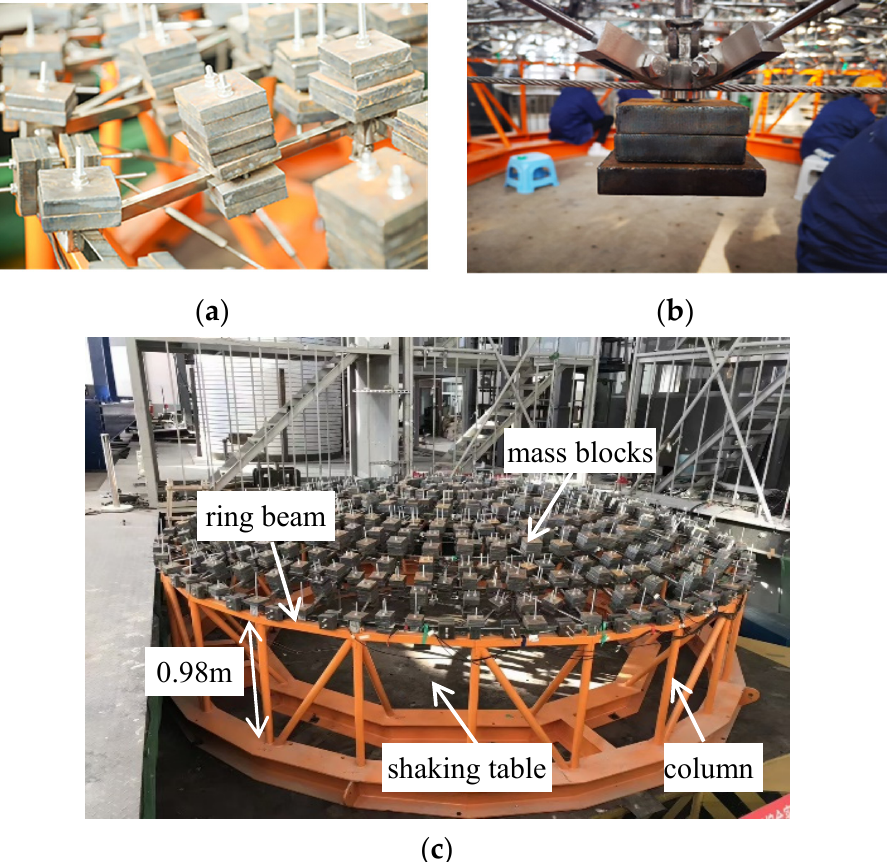
Figure 7. Test scale model: ( a ) Mass blocks of reticulated shell; ( b ) Mass blocks of cable-strut node; ( c ) Assembled model. Table 3. The similarity constants of the main physical parameters of the scale